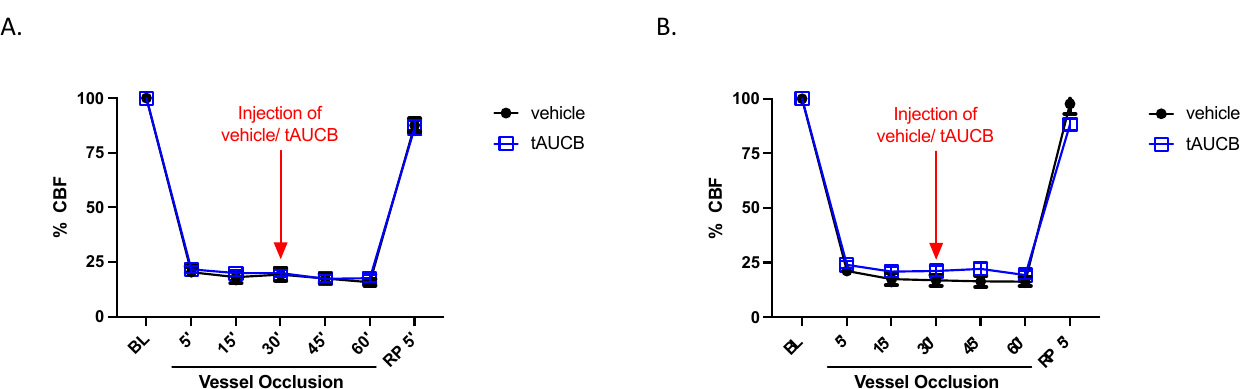
Figure 5. CBF is unaltered by tAUCB. CBF, assessed by laser Doppler probe, during and immediately after MCA occlusion does not differ between vehicle or tAUCB treated mice in either ( A ) non-diabetic, or ( B ) diabetic mice (BL, baseline; RP5’, 5 minutes reperfusion; n = 7–8/group).